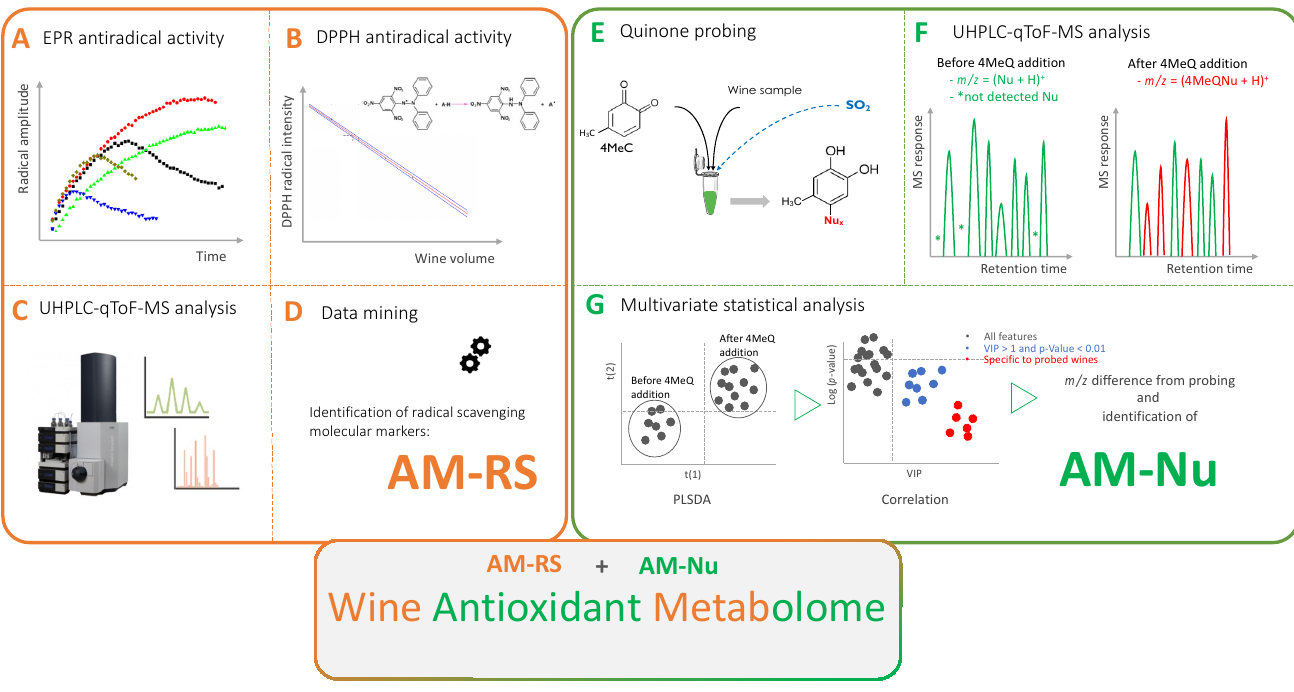
Figure 2. Schematic representation of wine antioxidant metabolome (AM) composed of antiradical scavenging (AM-RS) and nucleophilic (AM-Nu) related molecular markers. AM-RS molecular markers where isolated by applying the combination of powerful and modern analytical approaches: ( A ) EPR antiradical activity, ( B ) DPPH antiradical activity, ( C ) UHPLC-q-Tof-MS analysis and ( D ) data manning. AM-Nu molecular markers where isolated after: ( E ) one step derivatization step using the 4-methyl-1,2-benzoquinone (quinone) as a electrophilic molecular probe, ( F ) the mass difference statistical analysis.